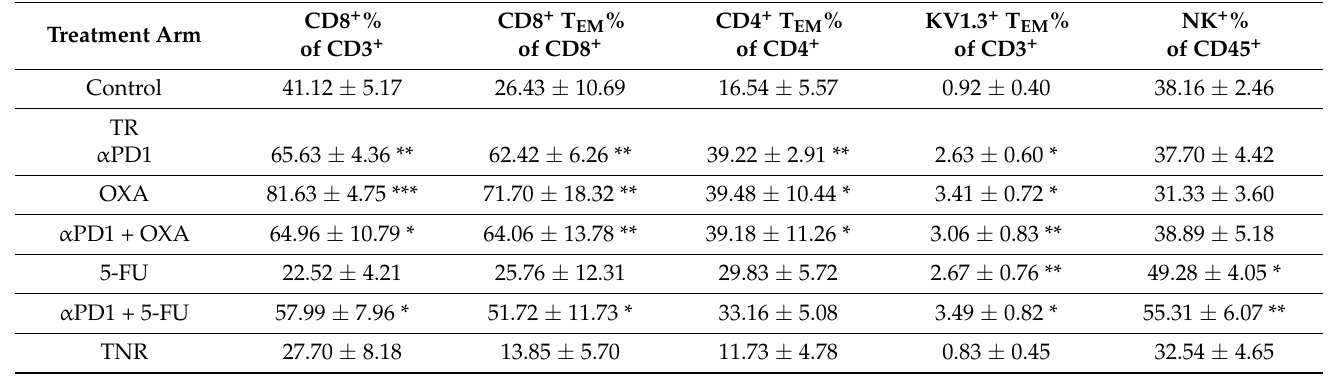
Table 2. Tumour-infiltrating i mmune cell populations in each treatment arm. Data are represented as % immune cell population ± S.D. comparing treated responders from each treatment arm (TR) to treated non-responders (TNRs) ( n = 5–10 mice/group; * p < 0.05, ** p < 0.01, *** p < 0.001 comparing TRs in each treatment arm to